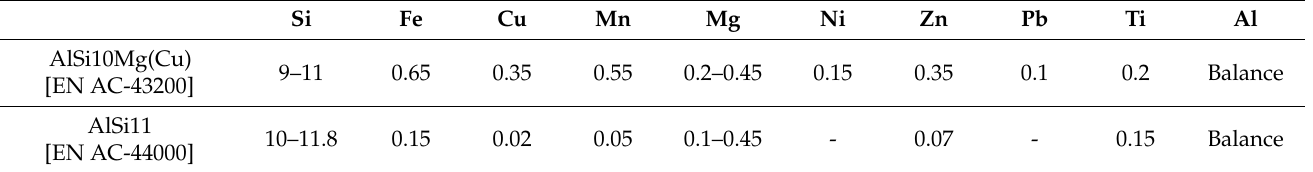
Table 2. Chemical composition (wt. %) of the cast alloys used in this